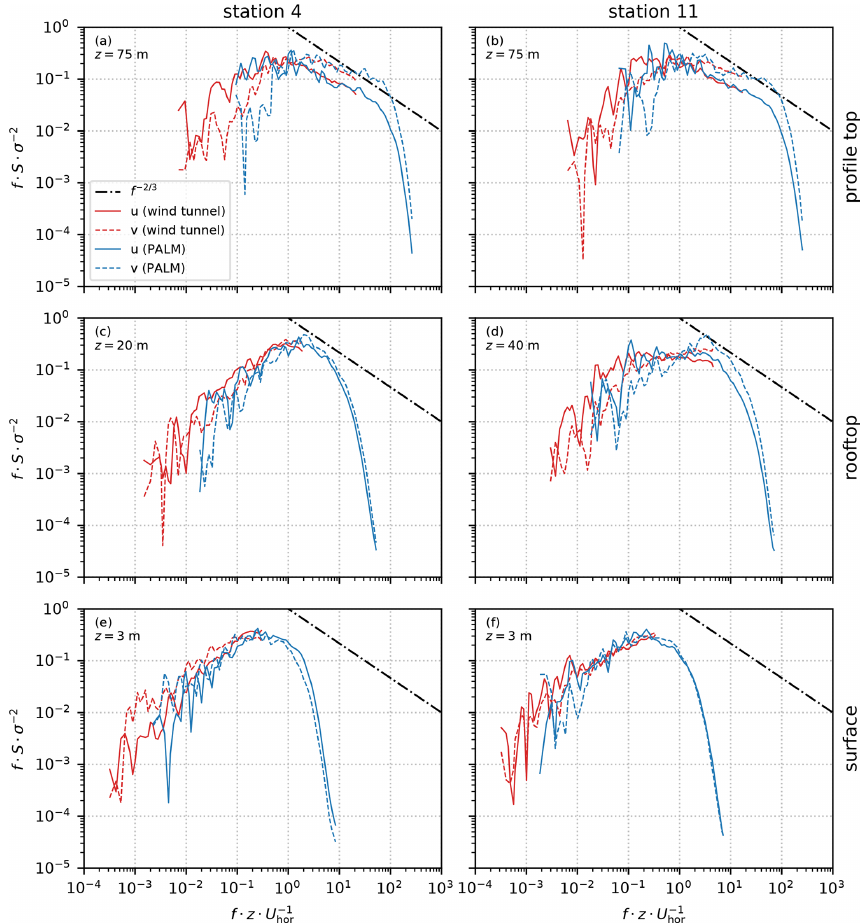
Figure 16. Spectral energy density S for u and v at station 4 (a, c, e) and station 11 (b, d, f) at profile top (a, b) , rooftop height (c, d) , and near the surface (e, f) . S is normalized by multiplying by the frequency f and dividing by the variance σ 2 . For reference, the dash-dotted 2 line shows a slope f − 3 indicating the slope of energy decay according to Kolmogorov’s theory. Note that z is given relative to street-level